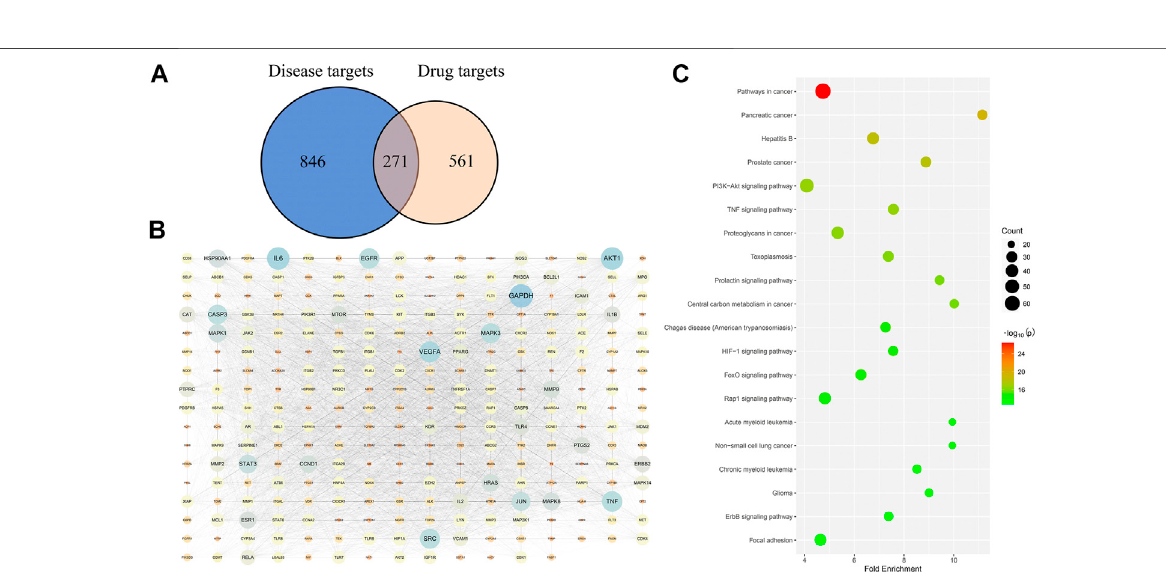
Frontiers in Pharmacology |